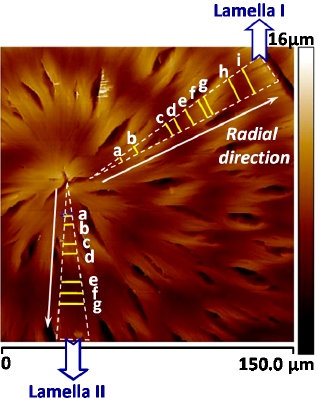
Figure 9. AFM height image on water-etched spherulites of PEO/PLLA (50/50) blend crystallized at T c = 110 °C and cooled to ambient. Two discrete macro-lamellae (I,II) marked for height profile analysis. Reprinted from Ref. [33]. Copyright (2012), with permission from Elsevier.